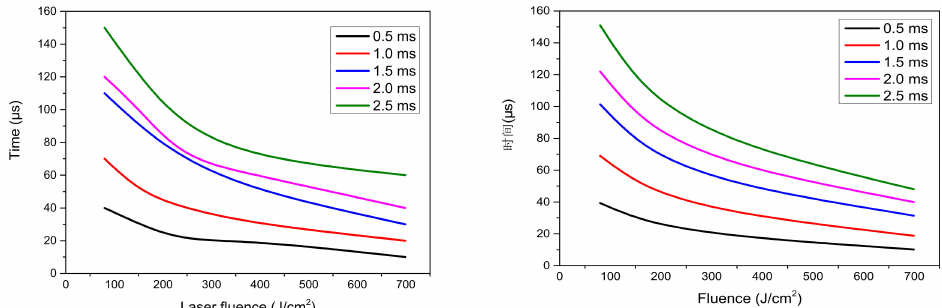
Figure 2. The relationship between the laser heating CFRP surface heating time and the energy density and pulse width under a single